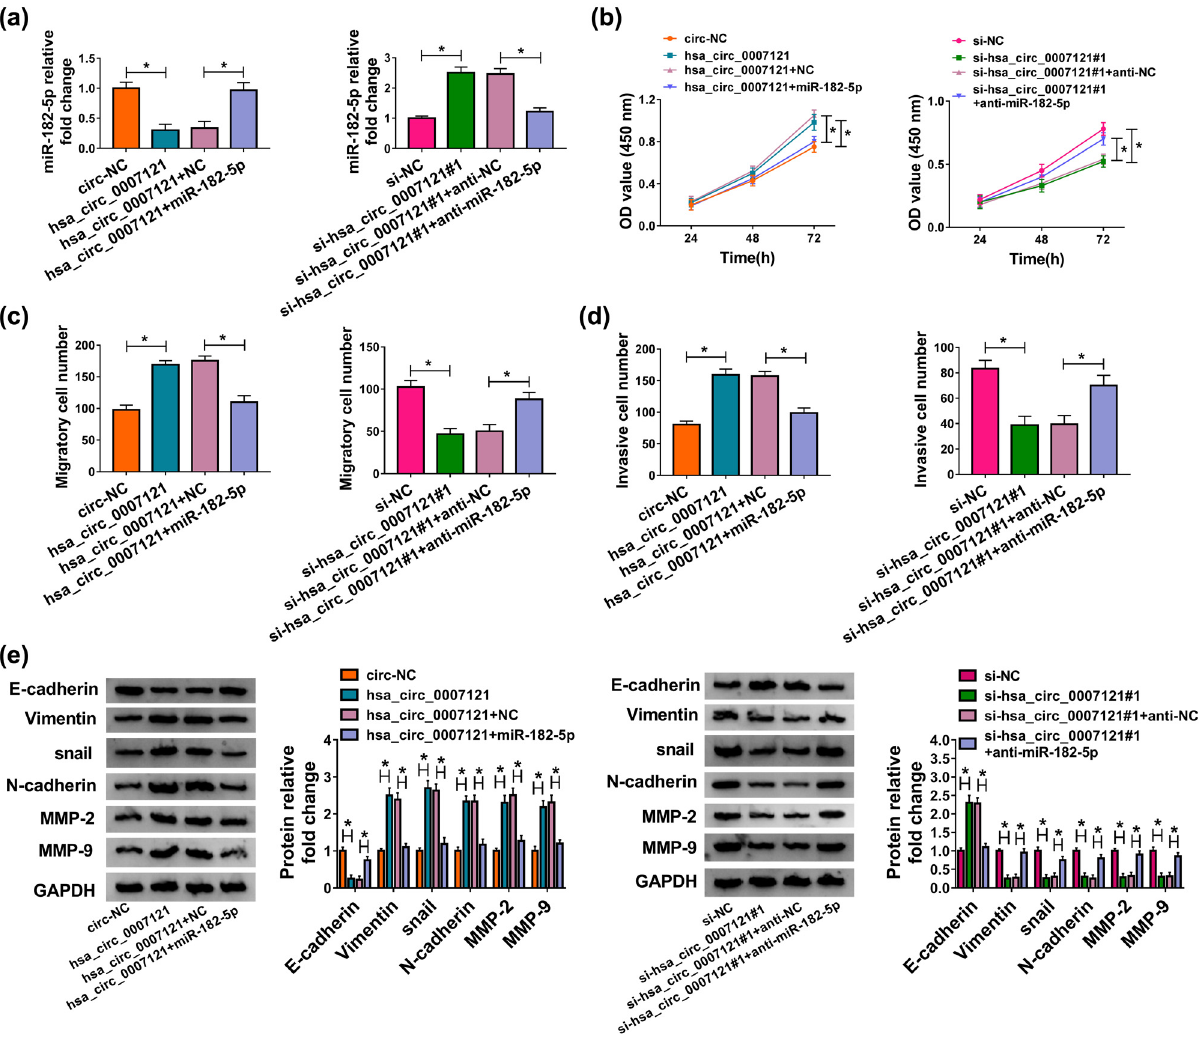
Figure 4: Hsa_circ_0007121 regulated PE progression by interacting with miR - 182 - 5p. ( a ) The level of miR - 182 - 5p in HTR - 8/SVneo cells transfected with hsa_circ_0007121, hsa_circ_0007121 + miR - 182 - 5p, si - hsa_circ_0007121#1, or si - hsa_circ_0007121#1 + anti - miR - 182 - 5p, as well as matched controls was checked by qRT - PCR. ( b ) The proliferation of transfected HTR - 8/SVneo cells was checked by the CCK8 assay. ( c and d ) The abilities of migration and invasion of transfected HTR - 8/SVneo cells were estimated by the transwell assay. ( e ) The protein levels of EMT - related proteins in samples were detected by Western blot. * P <